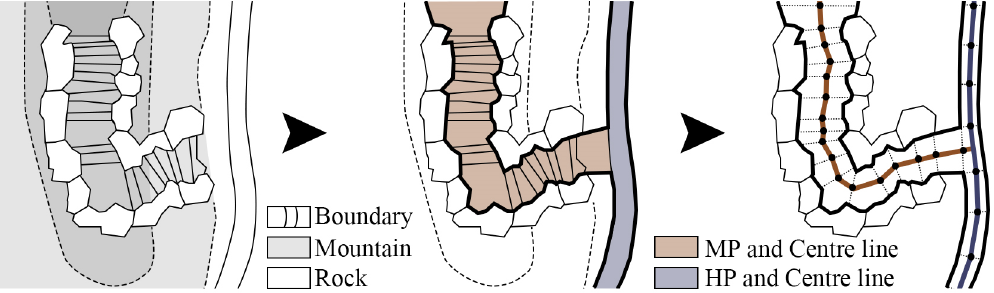
Figure 4. Determination of the path sideline and centreline, taking the Chunwangfu Garden as an example (left: historical original data; middle: determination of the path sideline; right: determination of the path centreline).